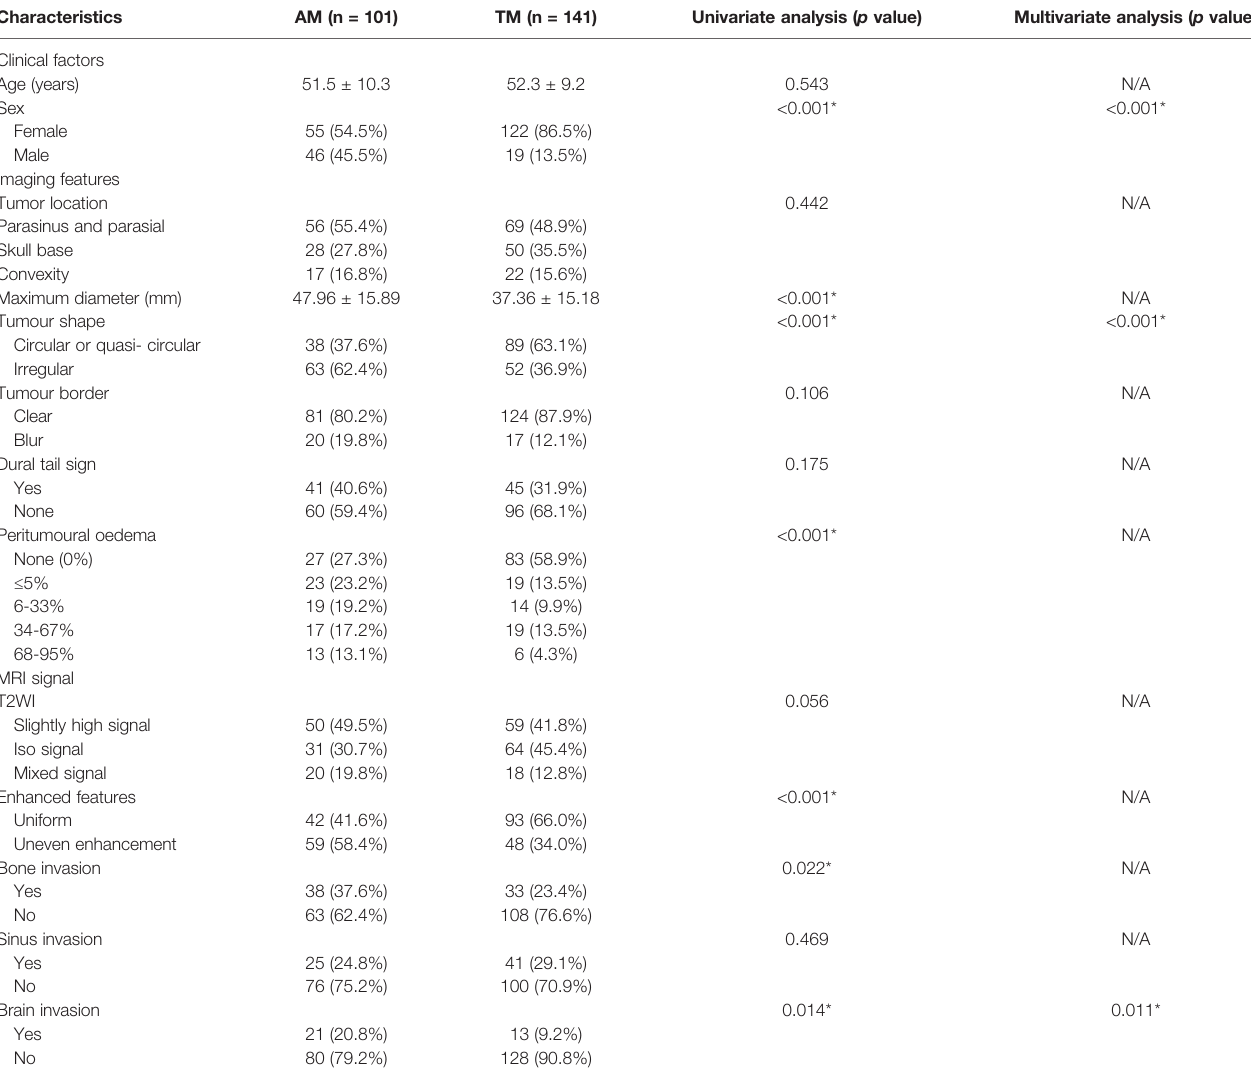
TABLE 1 | Clinical factors of the patients and magnetic resonance imaging features in the training and validation cohorts.